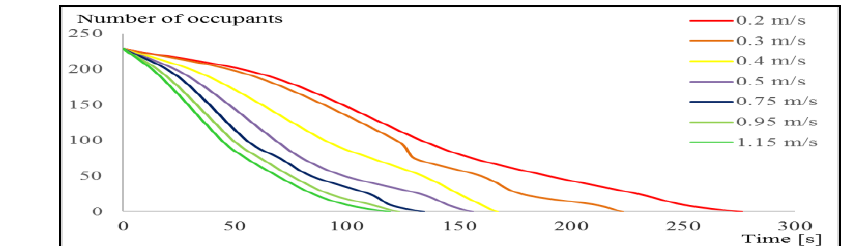
Figure 21 – Simulation results for the slowest times of the sixth case of the second scenario